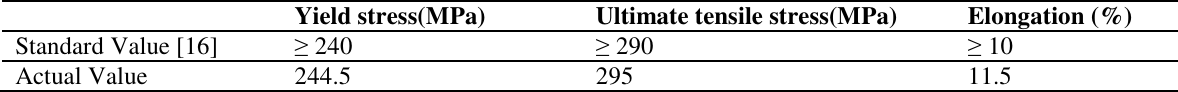
Standard and actual mechanical properties of aluminum alloy 6061-T6 Yield